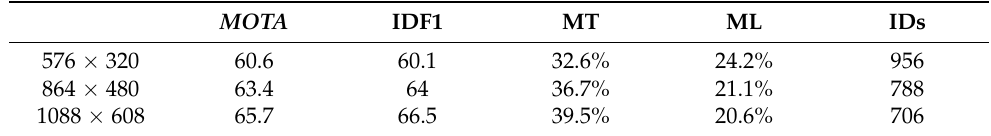
Table 3. Comparison between different input resolutions of the encoder. The results show that the resolution is essential to the performance of the model.